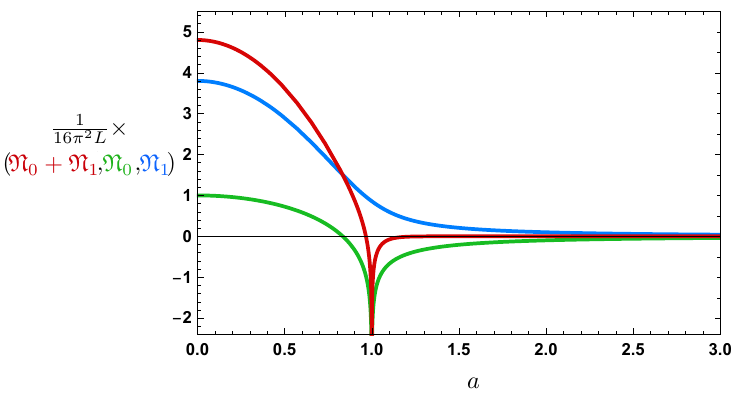
Figure 6 . The noise integrand N 0 + N 1 (red) de(cid:12)ned in eq. (A.3) as the sum of zero-point part N 0 (green) from eq. (A.4) and Bose-Einstein occupation number contribution N 1 (blue) from eq. (A.14), as a function of the rescaled time a = t=L . In this example, the functions are plotted for rescaled inverse temperature b = 1 =